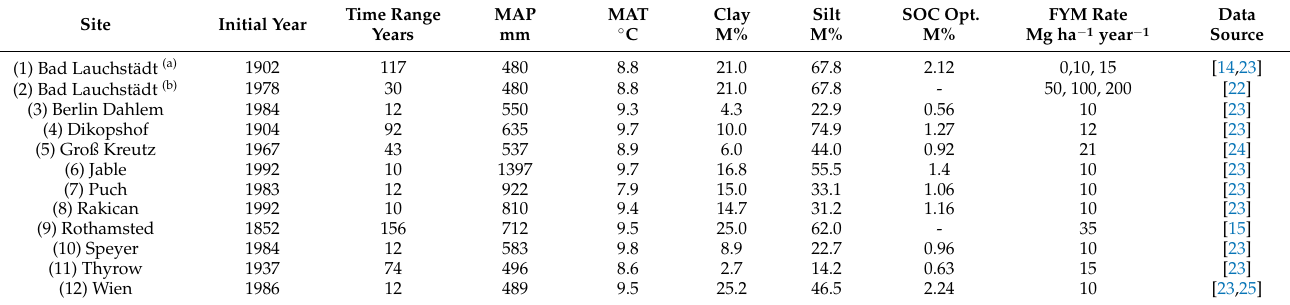
Table 1. LTFE metadata. Time range indicates the time until the last used soil sampling, MAP: mean annual precipitation, and MAT: mean annual temperature.